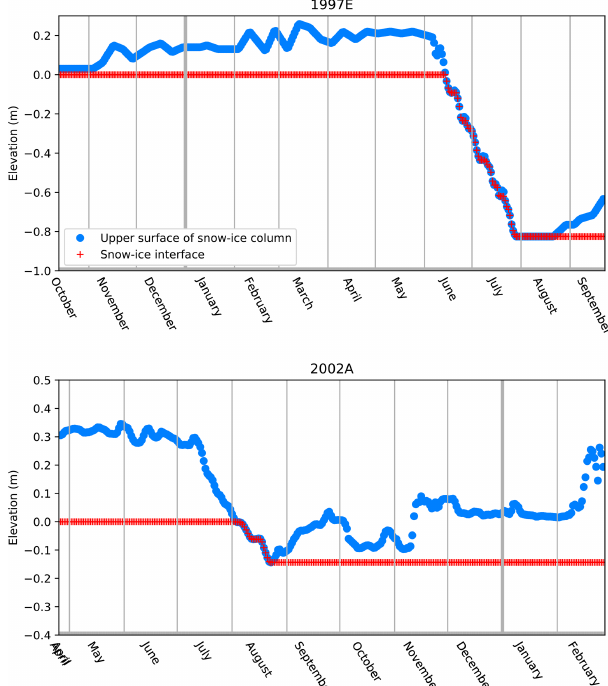
Figure 5. Two examples of estimating snow–ice interface from a regularized snow surface data series. The interface remains at a con- stant level unless the surface falls below this level, in which case the interface falls with the